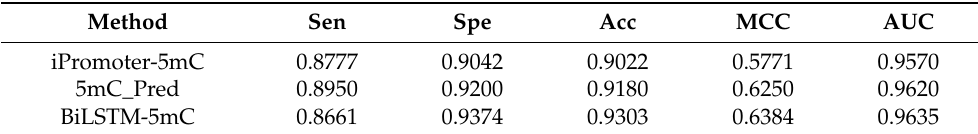
Table 3. Performance comparison on the independent testing dataset.